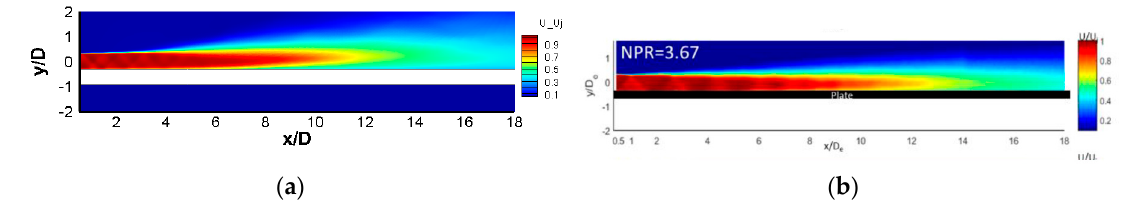
Figure 26. Time-averaged velocity non-dimensional by jet exit velocity (Shielded case). ( a ) Numerical (NPR = 3.67, TR = 3.0), ( b ) Experiment (NPR = 3.67, TR = 2.4) (Ref. [87]).